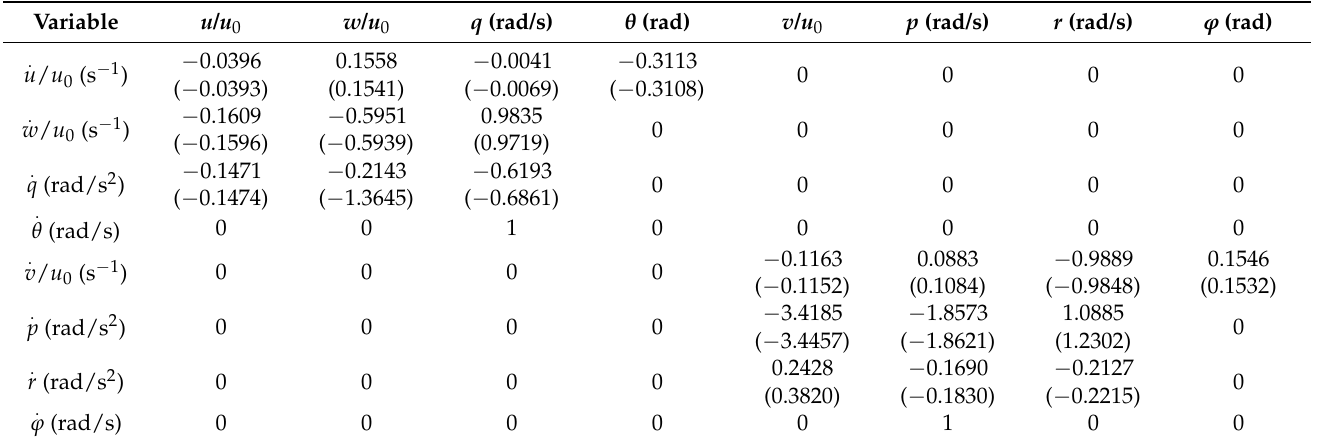
Table 20. CFD–RANS (extrapolated) 8 × 8 stability matrix for flight condition 14 in Tables 4 and 22 (reference takeoff case).